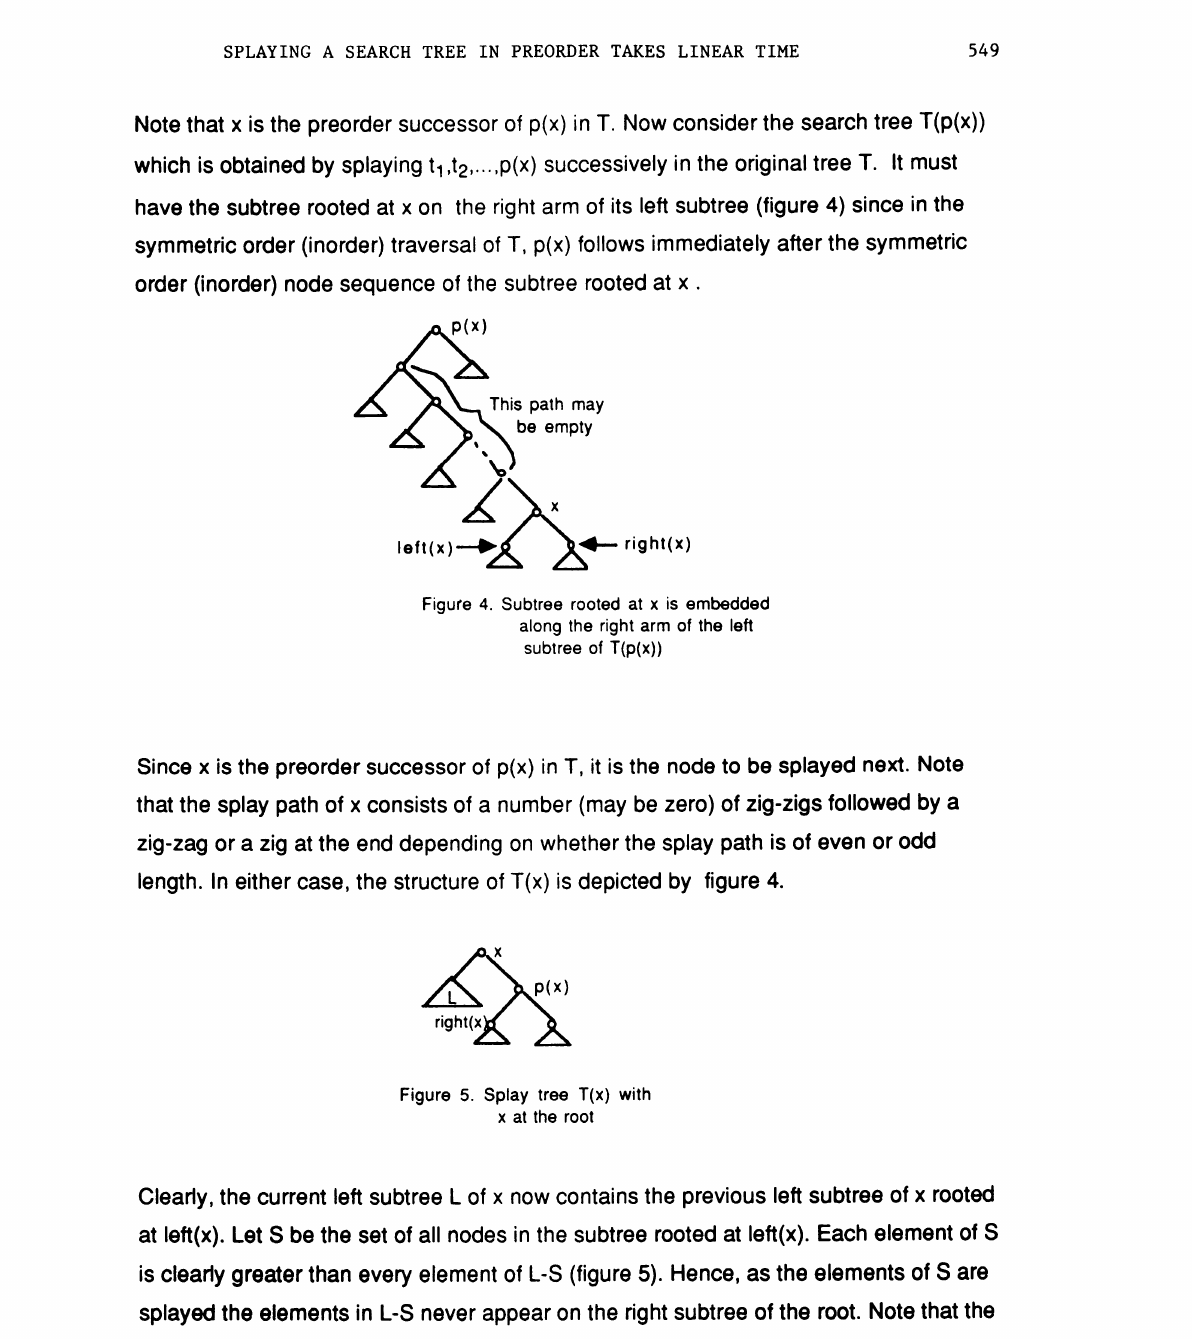
Figure 5. Splay tree T(x) with at the